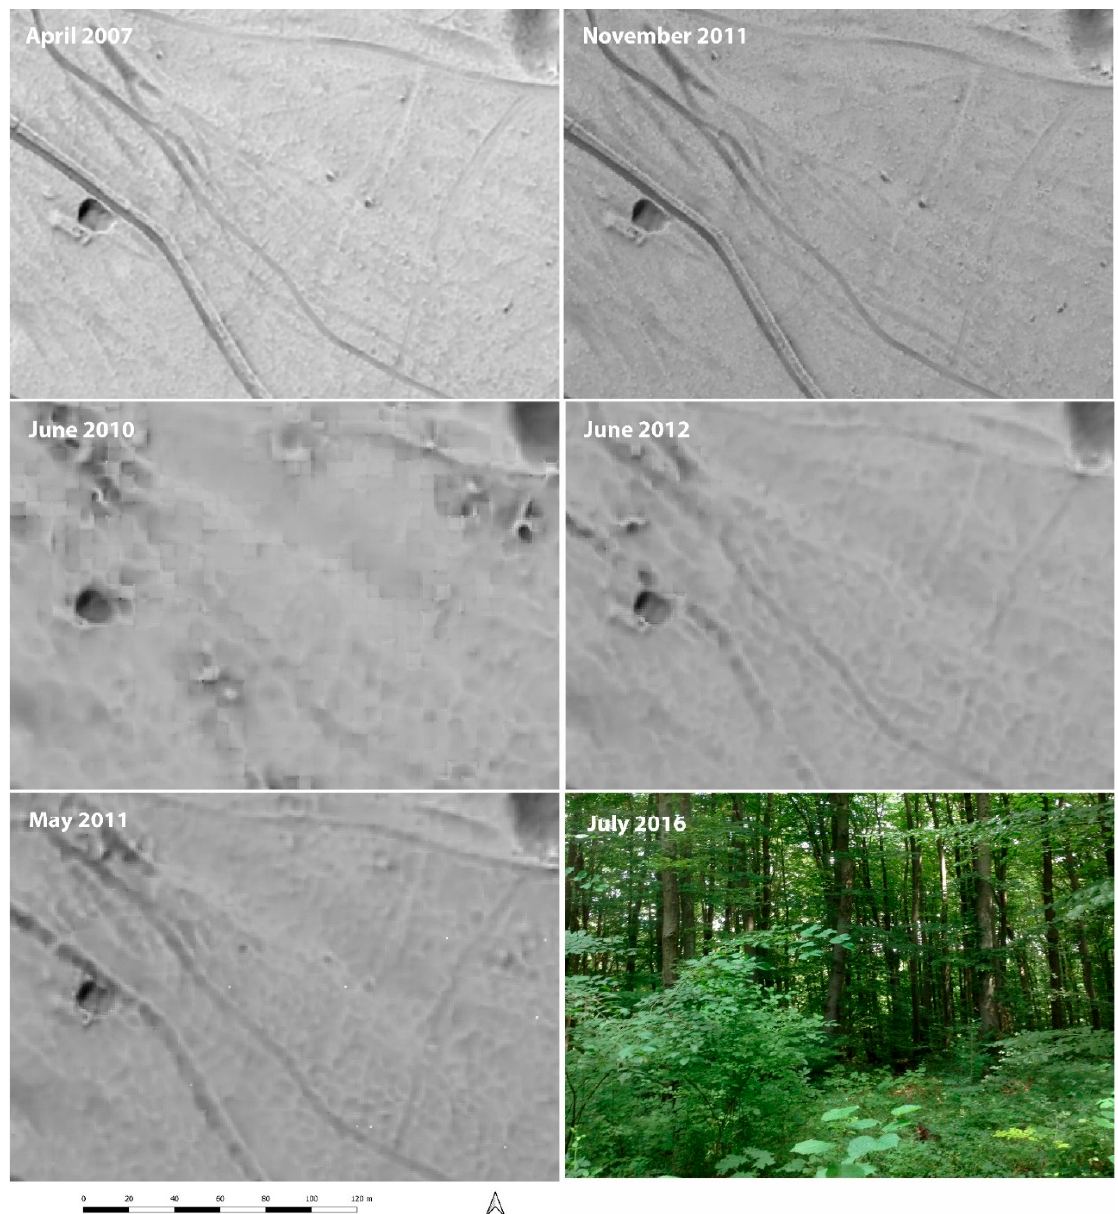
Figure 20. Part of a network of hollow ways in Area 3. All visualizations are a combination of positive openness (with colour gradient black to white, stretch to min–max, min. 1.41–max. 1.58) and hillshade (photograph by Ł . Banaszek).